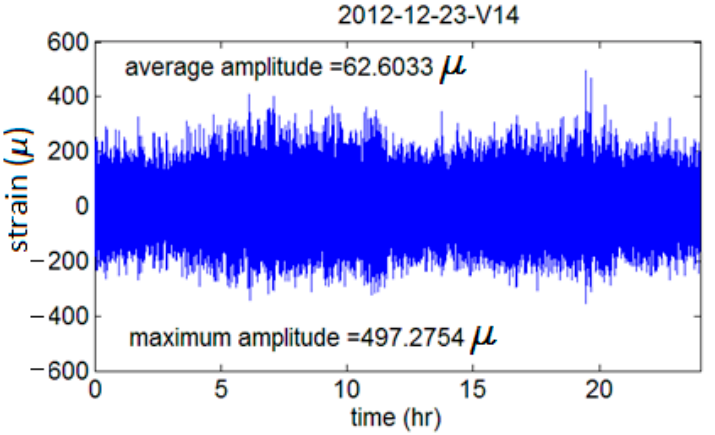
Figure 3. Measured strain at location V14 on the support frame.